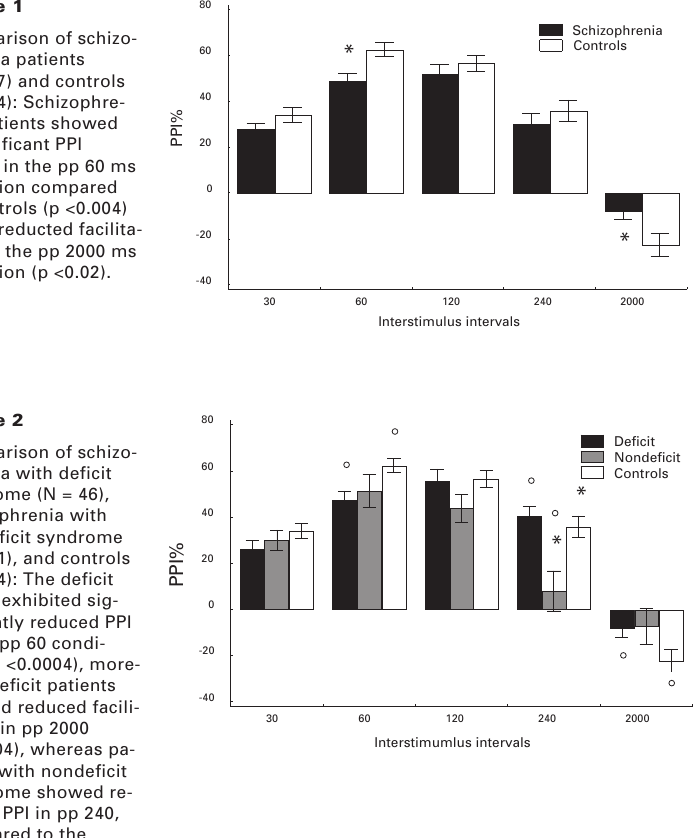
Comparison between deficit (N = 28) and nondeficit schizo- phrenia (N = 14), only treated with atypical antipsychotics, and controls (N = 44): The increased PPI of PP condition 60 ms in deficit (p <0.006) and of PP condition 240 ms in non deficit schizophrenia (p <0.008) was also seen in patients re- ceiving atypical anti- psychotics